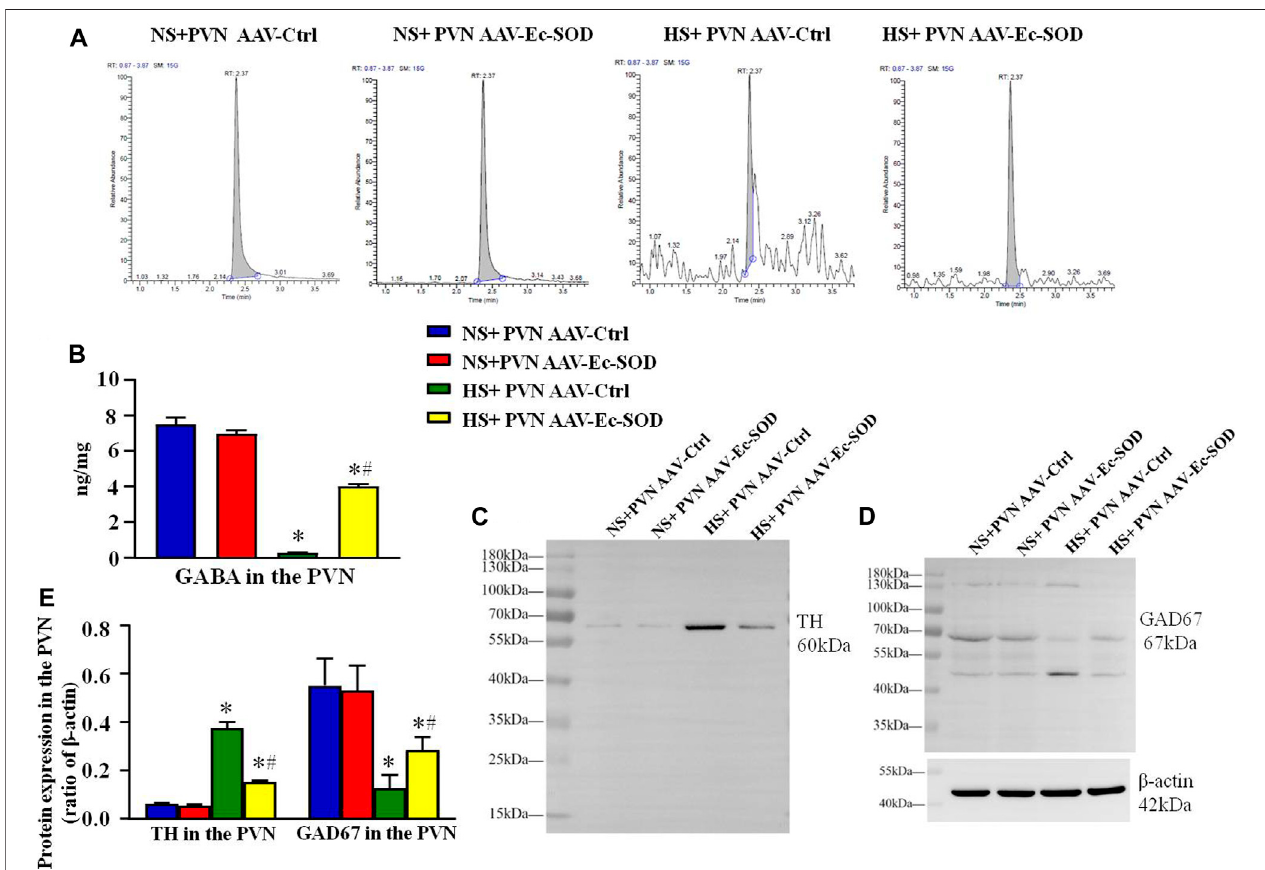
FIGURE 7 | Effect of AAV-Ec-SOD on the neurotransmitter-related proteins in the PVN (A) High-performance liquid chromatography chromatograms of GABA in the PVN in different groups. (B) Column diagram for the PVN level of GABA in different groups. (C – D) Representative immunoblot and (E) densitometric analysis ofPVN expressionlevelsofTHandGAD67inthedifferentgroups.Valuesareexpressedasmean ± SEM(n (cid:2) 4 – 6).* p < 0.05NS+PVNAAV-Ctrl vs. HS+PVNAAV-Ec-SOD; # p < 0.05 HS + PVN AAV-Ctrl vs. HS + PVN AAV-Ec-SOD.